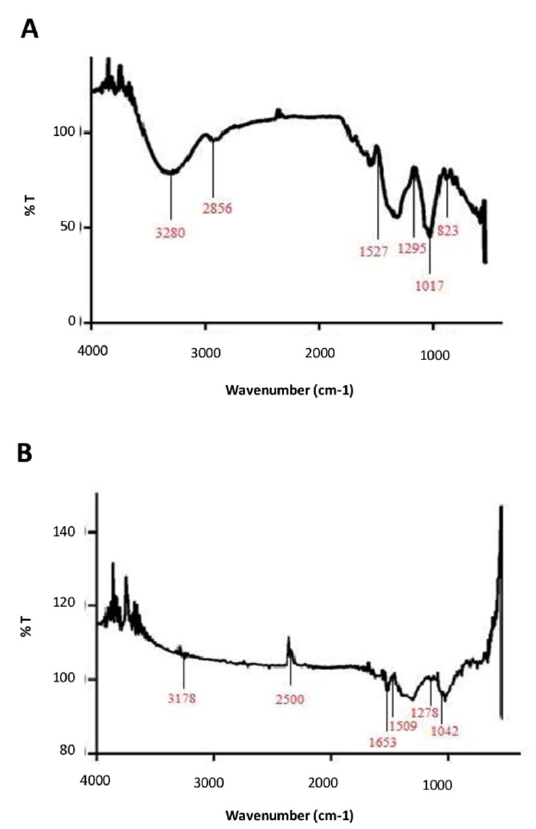
Figure 4. FT-IR analysis of ( A ) AgNPs and ( B ) FT-IR analysis of silver chitosan nanoparticles. Figure 4. FT ‐ IR analysis of ( A ) AgNPs and ( B ) FT ‐ IR analysis of silver chitosan nanoparticles. Table 3. FT-IR analysis of AgNPs. Table 3. FT ‐ IR analysis of AgNPs.